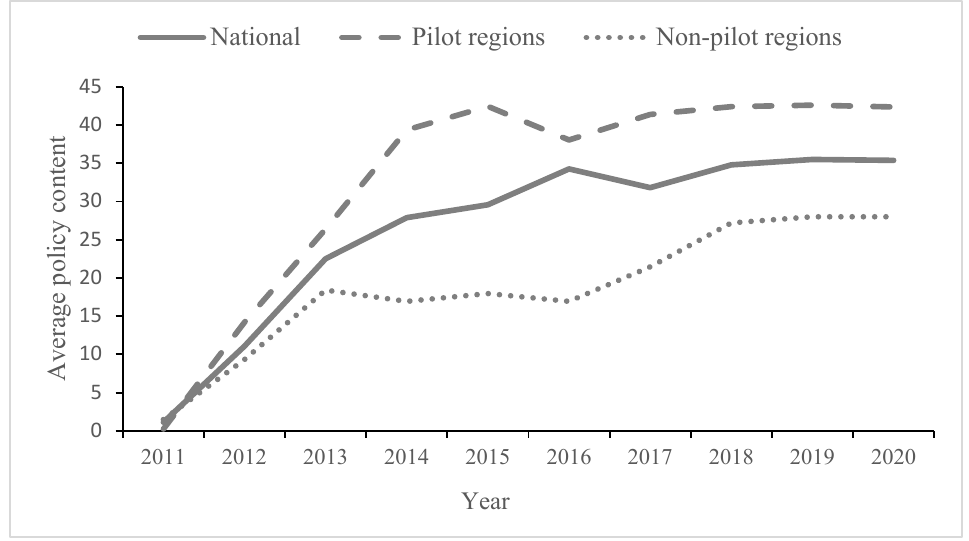
Figure 4. Comparison of the average content validity of CET policy (2011–2020). (Note: the data supporting the figure were calculated by the authors).